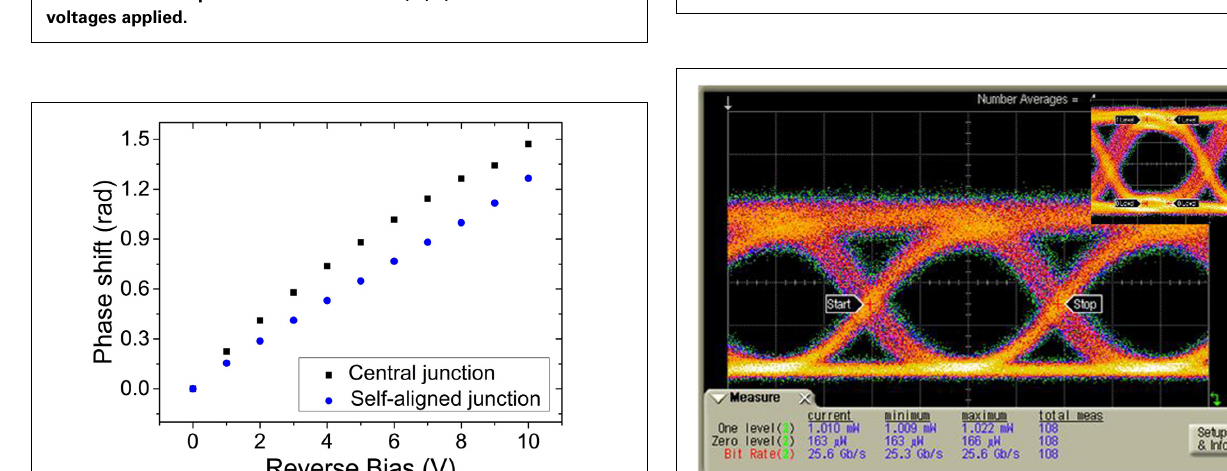
FIGURE 4 | Modulation efficiency vs. reverse bias voltage for the central junction and self-aligned junction devices.